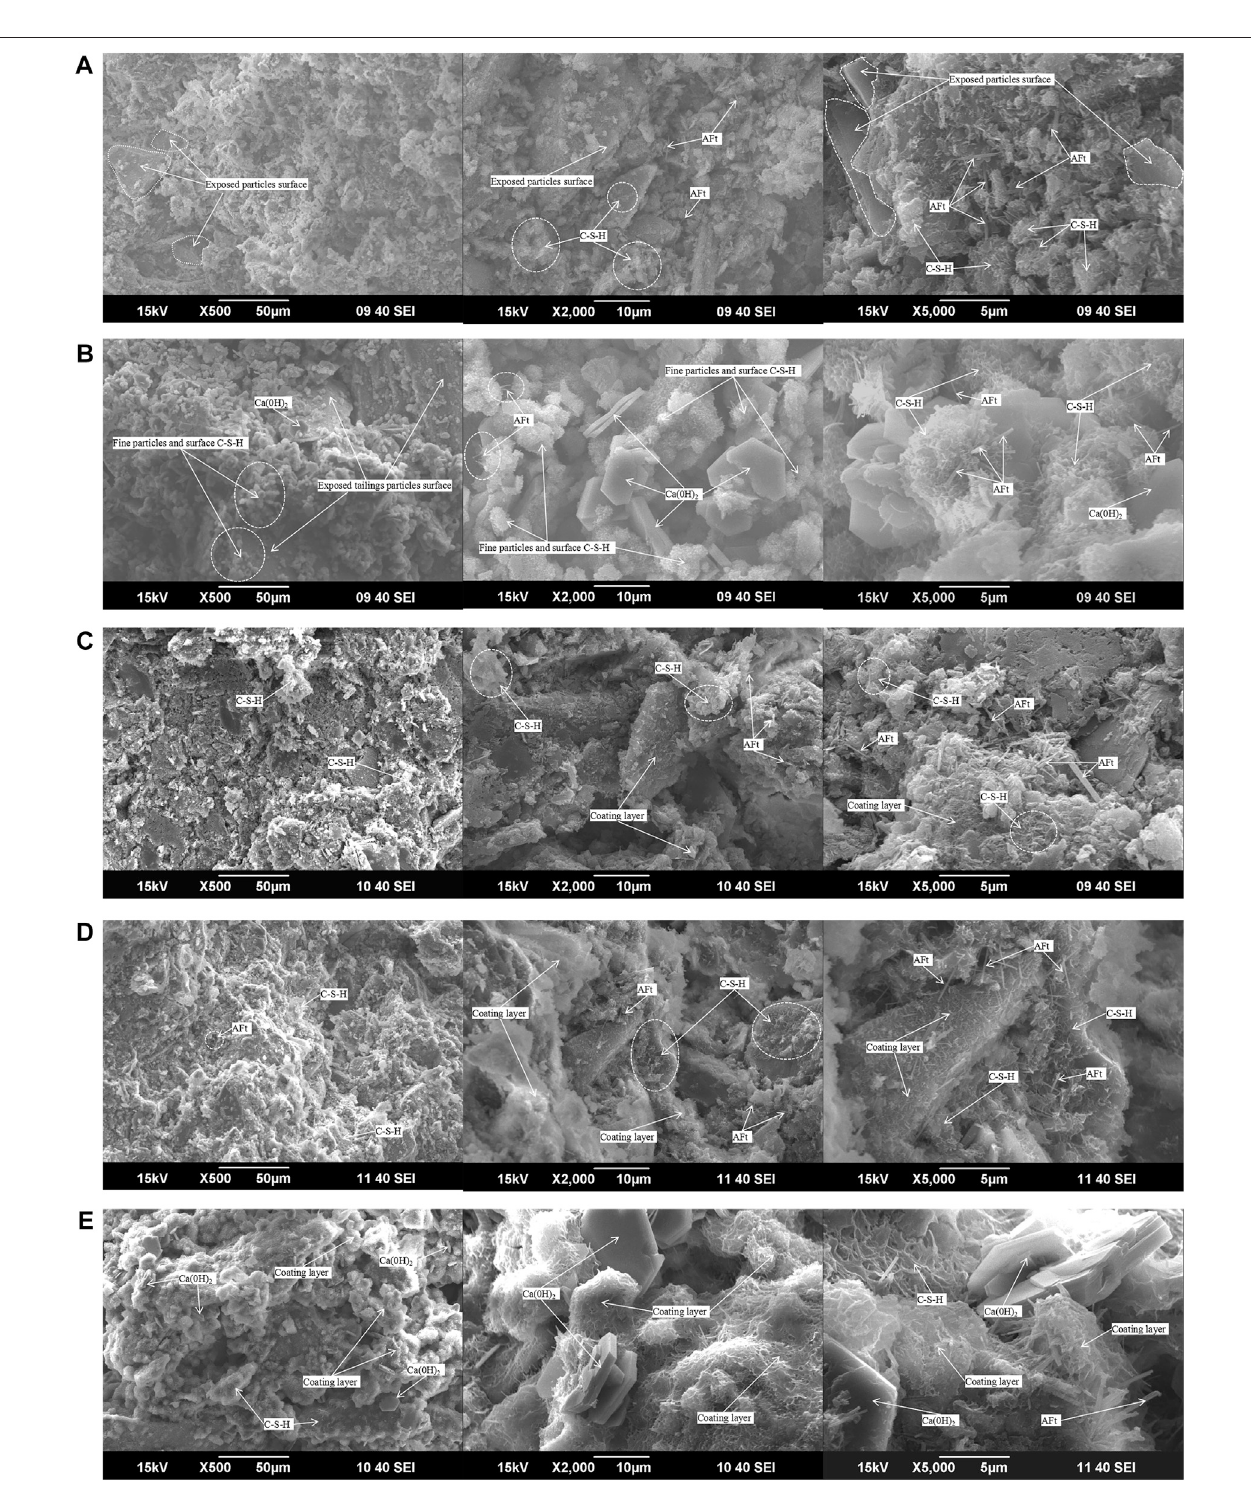
FIGURE9| SEMimagesofCPBwithdifferentC/Tratioandcuringage: (A) CUTB,C/Tratio1:4,curingageof3 days; (B) CCTB,C/Tratio1:4,curingageof3 days; (C) CUTB, C/T ratio 1:4, curing age of 7 days; (D) CUTB, C/T ratio 1:4, curing age of 28 days; (E) CCTB, C/T ratio 1:4, curing age of 28 days.